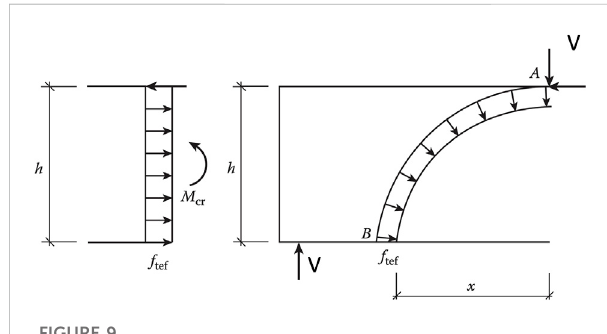
FIGURE 9 Stress distribution across diagonal crack.